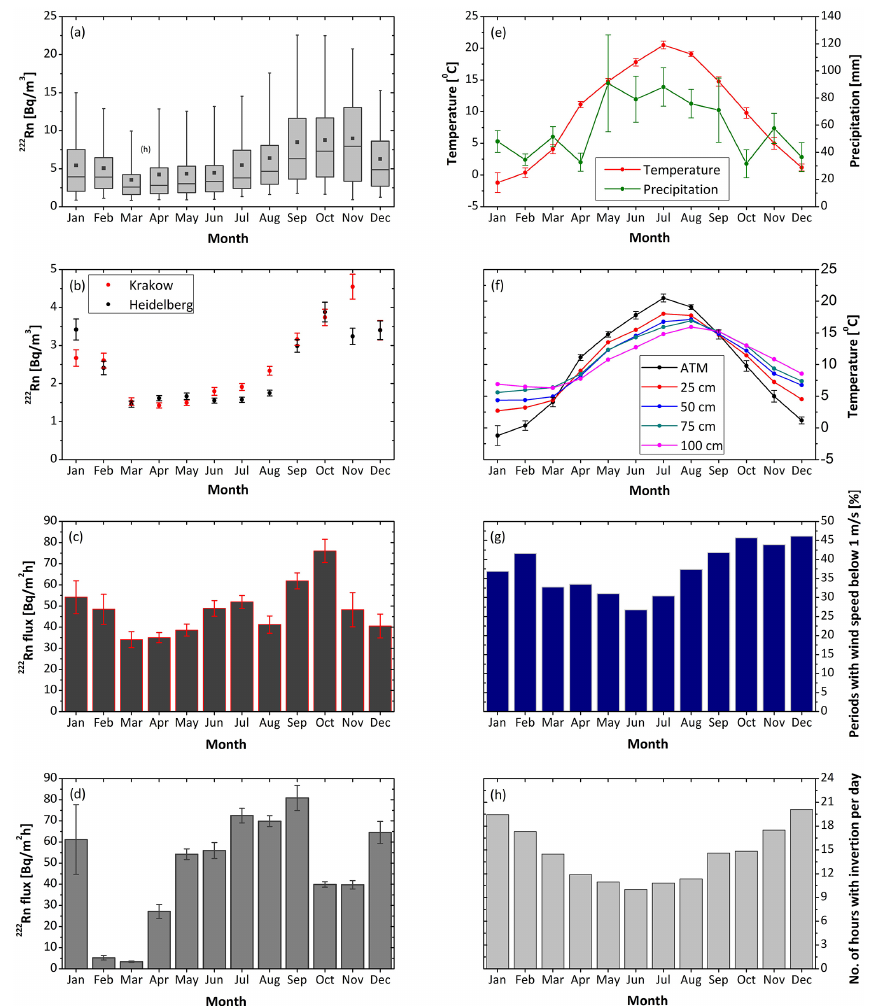
Figure 8. (a) Box-and-whisker plot of monthly 222 Rn concentration measured in the near-ground atmosphere of Krakow. The median is represented by horizontal line, while the arithmetic average is shown by a full dot. (b) Monthly minima of atmospheric 222 Rn content, as observed in Krakow and Heidelberg, calculated as arithmetic averages of daily 222 Rn minima for the given month, averaged over the entire observation period from January 2005 till December 2009. (c) Monthly means of night-time 222 Rn fluxes in Krakow, averaged over the period from June 2004 till May 2009. (d) Monthly means of soil 222 Rn fluxes in Krakow derived from chamber measurements, averaged over the period from September 2005 till September 2006. (e) Monthly means of surface air temperature and precipitation in Krakow, averaged over the period from January 2005 till December 2009. (f) Monthly means of surface air and soil temperatures in Krakow. (g) Percentage of periods with wind speed below 1ms − 1 in Krakow, averaged over the period from January 2005 till December 2009. (h) Monthly means of number of hours with ground-based inversion per day, averaged over the period from January 1994 till December